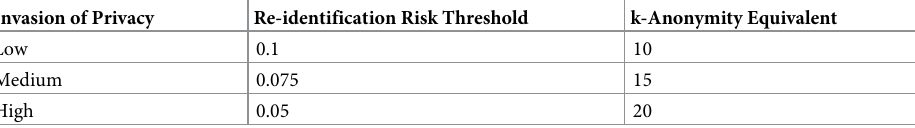
Table 2. Acceptable risk thresholds for different levels of privacy invasion suggested by the Ontario Information and Privacy